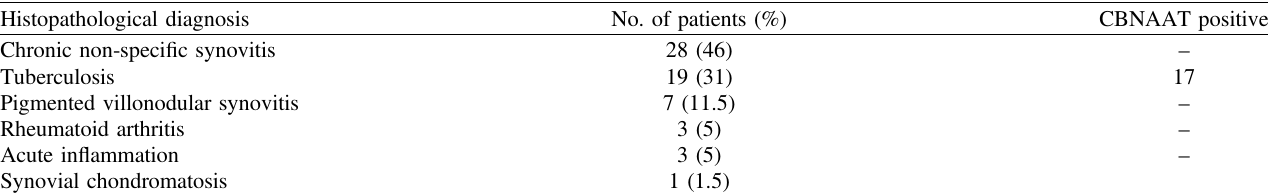
Table 3. Comparison between histopathology and CBNAAT results.